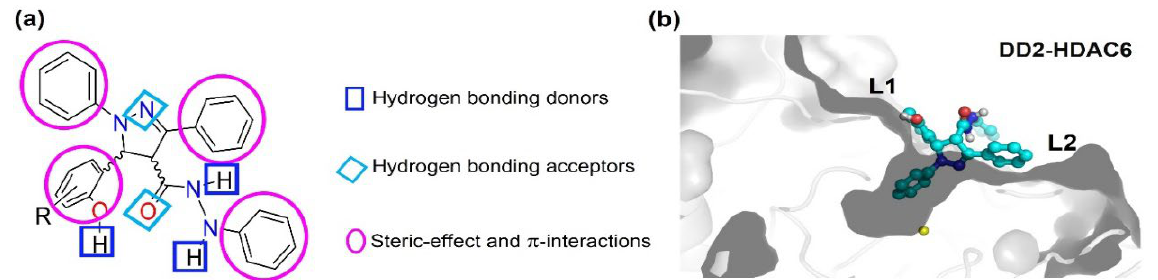
Figure 2. ( a ) Steric effects and noncovalent interactions considered as structural design elements of compounds 2a–i . ( b ) The expected method for compounds 2a–i to cap the entrance of the active site cleft through noncovalent binding interactions in the shallow L1 and L2 pockets.